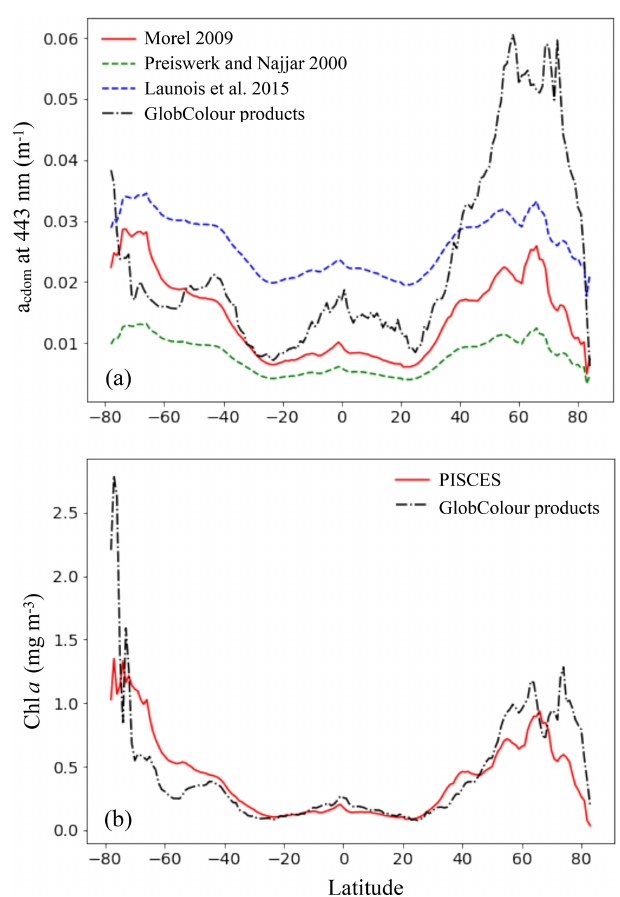
Figure 8. Comparison of the CDOM absorption coefficient at 443nm (a) and Chl a (b) simulated by PISCES with GlobColour products averaged over 2002–2012, as a function of latitude. For the CDOM absorption coefficient, the different parameterizations tested are